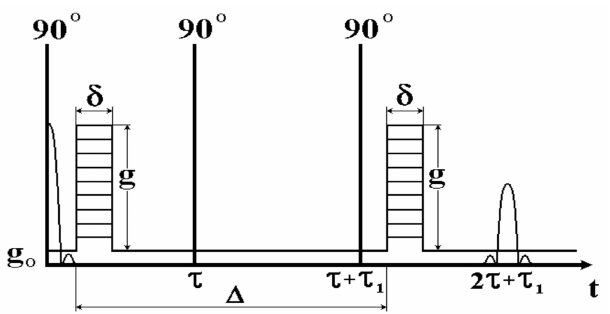
Figure 3. Sequence of stimulated echo with pulsed magnetic field gradient